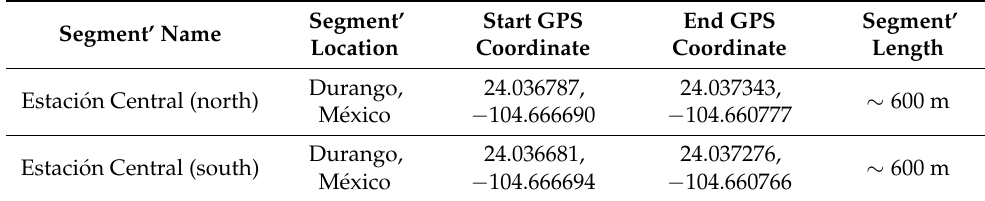
Table 30. Avenues’